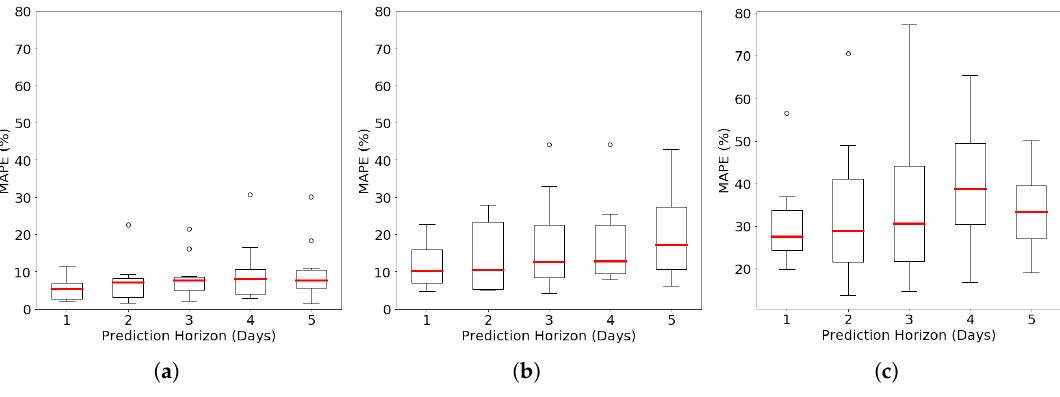
Figure 6. Distribution of the prediction MAPE over different duration of training data for varying duration of prediction horizons using GPR. ( a ) CMU electricity load; ( b ) Y2E2 cooling load; ( c ) Y2E2 lighting